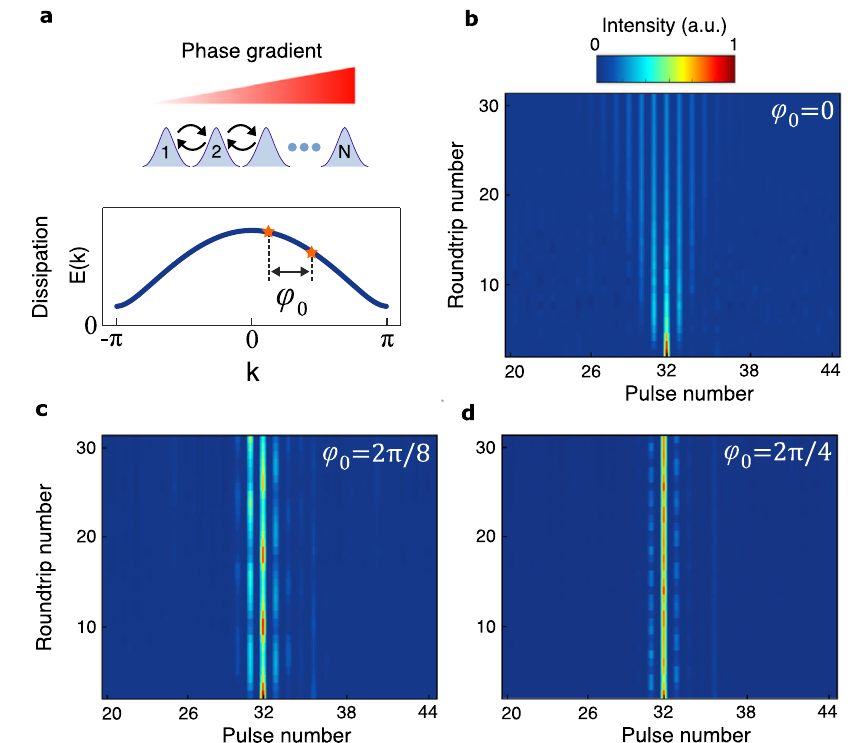
Fig. 2 | Experimental demonstration of Bloch oscillations in a uniform, dissipatively-coupledopenlattice.a Applyingaphasegradientamongthepulses in the time-multiplexed networktransportstheassociated Bloch eigenstates inthe reciprocal space by a value of δ k = ϕ 0 per cavity roundtrip, where ϕ 0 denotes the pulse-to-pulse phase differences induced by the intracavity phase modulator. b to d , Pulse intensity measurements associated with ϕ 0 =0,2 π /8 and 2 π /4, respec- tively.Inallcases,opticalpowerisinitiallylaunchedintoonelatticeelement(pulse